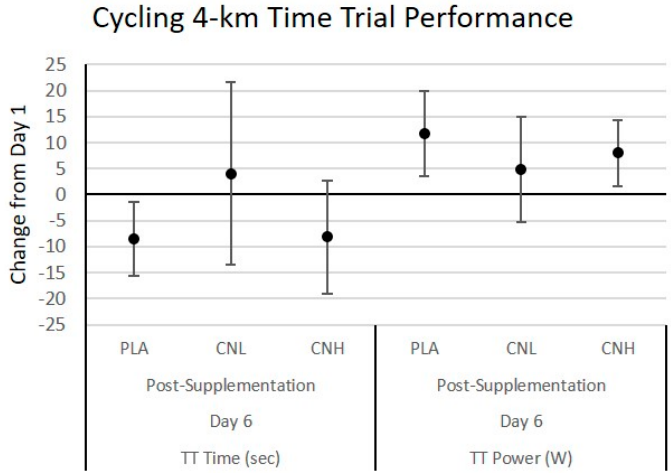
Figure 6. Change in 4 km cycling time trial performance from day 1 to day 6 for the placebo (PLA), low dose creatine nitrate (CNL), and high dose creatine nitrate (CNH) treatments. Data are mean changes (95% CI). Confidence intervals not crossing zero are statistically significant ( p < 0.05).